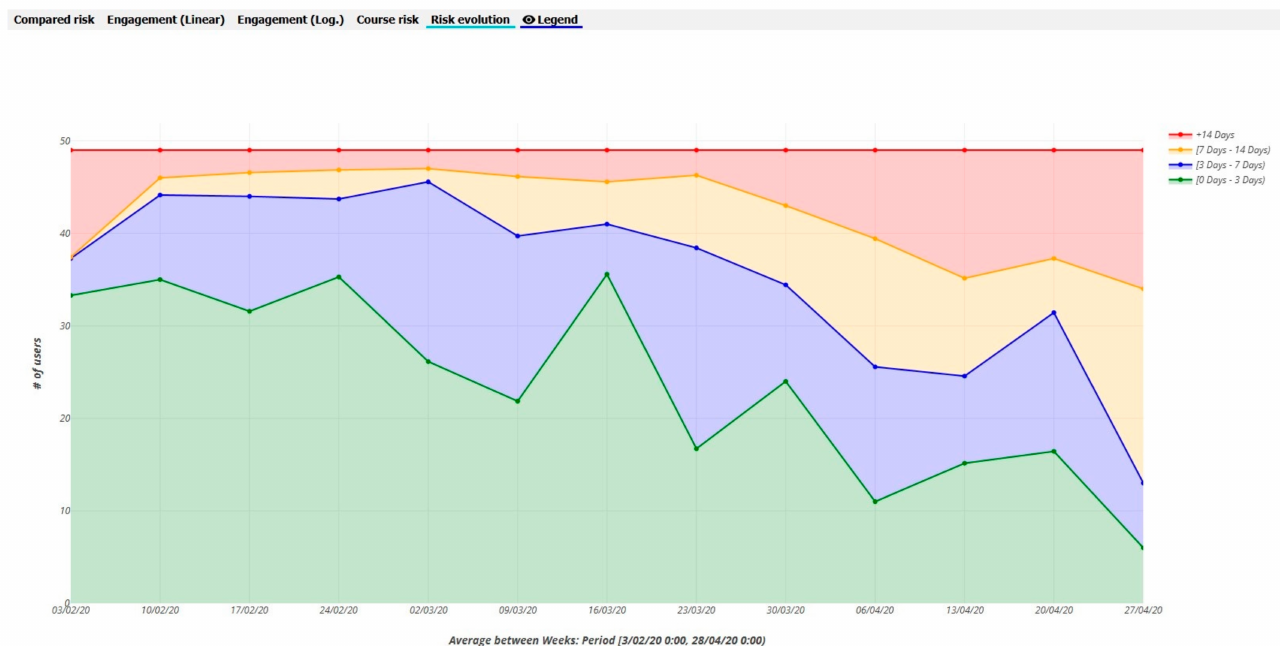
Figure 8. Graph of the evolution of the risk of abandonment (not access to the LMS) over the semester and analysed by week using the UBUMonitor tool